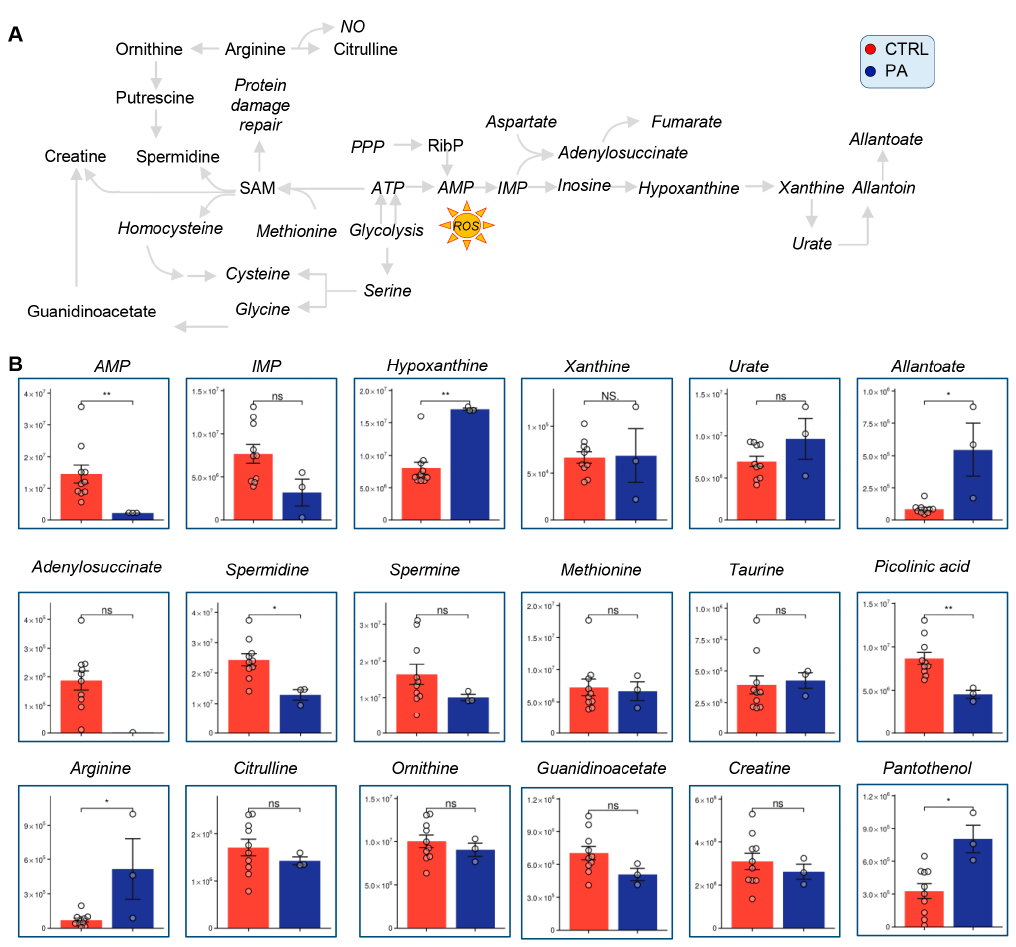
Figure 4. PA RBCs show different levels of purine and arginine metabolism indicating altered oxidative stress. Sum- mary of purine, arginine, and methionine metabolism ( A ) and bar plots with superimposed dot plots of key metabo-lites in these pathways ( B ). Y-axes represent peak area (arbitrary units). Asterisks indicate significant results, error bars represent ± standard error of the mean (unpaired t -test, 2-tailed distribution, * p < 0.05, ** p <